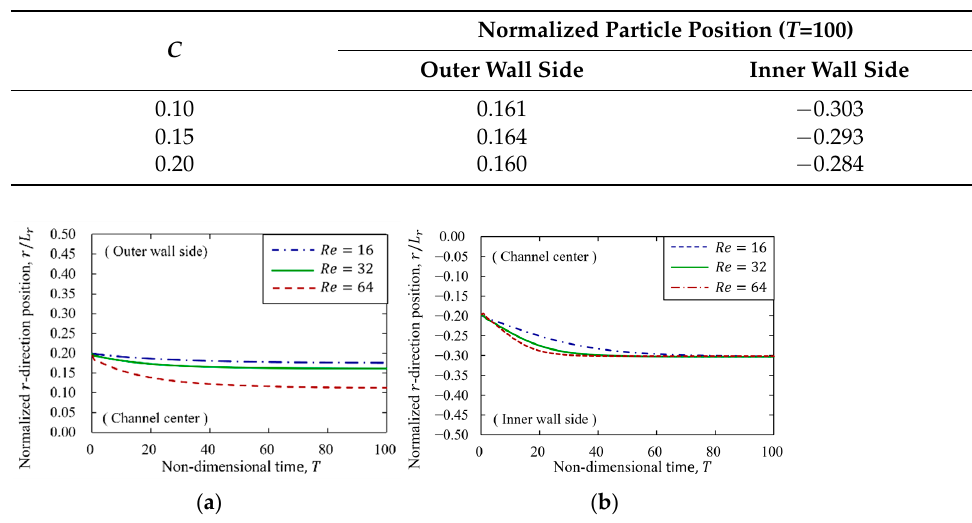
( b ) Figure 13. Inertial lift force acting on the particle at each 𝑟 -direction position. ( a ) confinement 𝐶 dependence. ( b ) Reynolds number 𝑅𝑒 dependence. In general, the equilibrium position of particles in a straight channel is discussed in terms of the balance of mechanical forces, mainly the lift force acting on finite-size parti- cles due to the velocity gradient and the repulsive force between the particle and the wall. Previous studies have suggested that the particle equilibrium position moves to the center of the channel with the increase in the repulsive force from the wall surface due to the increase in particle size [52]. In addition, the particles move in the direction of the wall surface when the Reynolds number increases because of the increase in the lift force in the direction of the wall acting on finite-size particles caused by the increase in velocity gra- dient [13]. However, the inner and outer walls of a two-dimensional curvilinear channel were found to yield asymmetric equilibrium positions with respect to the channel center. These results suggested that there are other factors in addition to the velocity gradient and the repulsive force from the wall that determine the equilibrium position. This is because the equilibrium position on the outside of the channel does not move toward the channel center (Figure 11a). Figure 11a shows the times history of particle migration on the outer wall for varying confinement 𝐶 . Due to the increased repulsive force from the wall surface, the equilib- rium positions were expected to shift toward the channel center. However, there was no significant change in particle equilibrium position with respect to the confinement effect.